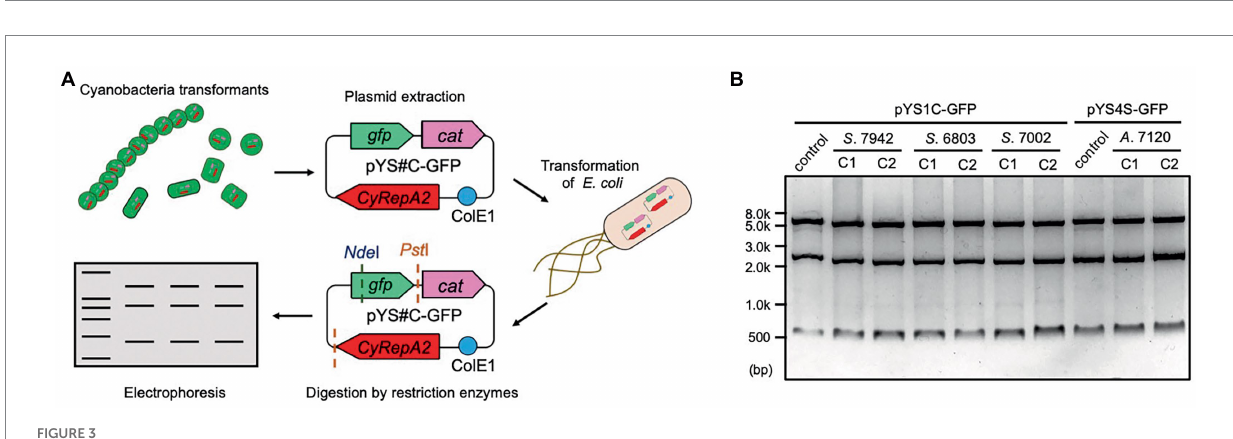
FIGURE 3 Plasmid structure of pYS in cyanobacteria cells. (A) Scheme of the analysis of plasmid structure. To determine whether plasmids are maintained in cyanobacterial cells in a circular structure, DNA was extracted from cyanobacteria transformants ( S . 7942, S . 6803, S . 7002, and A . 7120) carrying pYS1C-GFP or pYS4S-GFP and introduced into E. coli . After the plasmid was extracted from the E. coli cells, plasmids were digested with restriction enzymes, and compared to the plasmids before the transformation of cyanobacteria. (B) Electrophoresis image of plasmids digested by the restriction enzymes. The plasmids before transformation were used as controls. The results of two independent clones are shown as C1 and